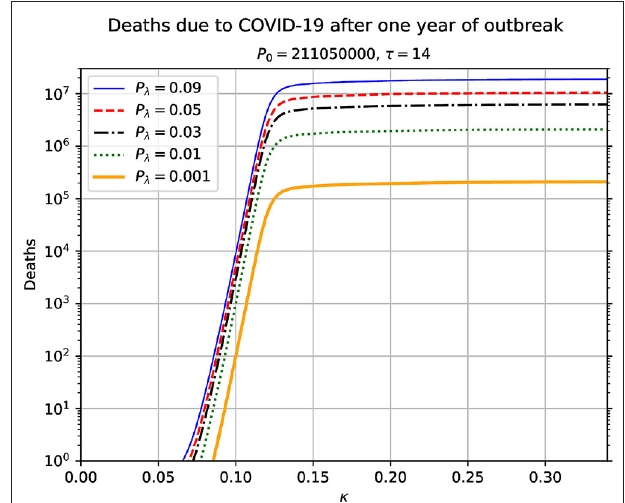
FIGURE 2 | Total number of accumulated deaths due to the epidemic as a function of the contagion rate κ . The total time duration for each value of κ is 365 days. This result shows the high sensitivity of the model time evolution on the contagion rate. The used parameters in this simulation are indicated above the figure. In each case, it is assumed that κ remains constant during the time span of the simulation. The value of κ that corresponds to R 0 κ ∗ µ 1 /τ = + =